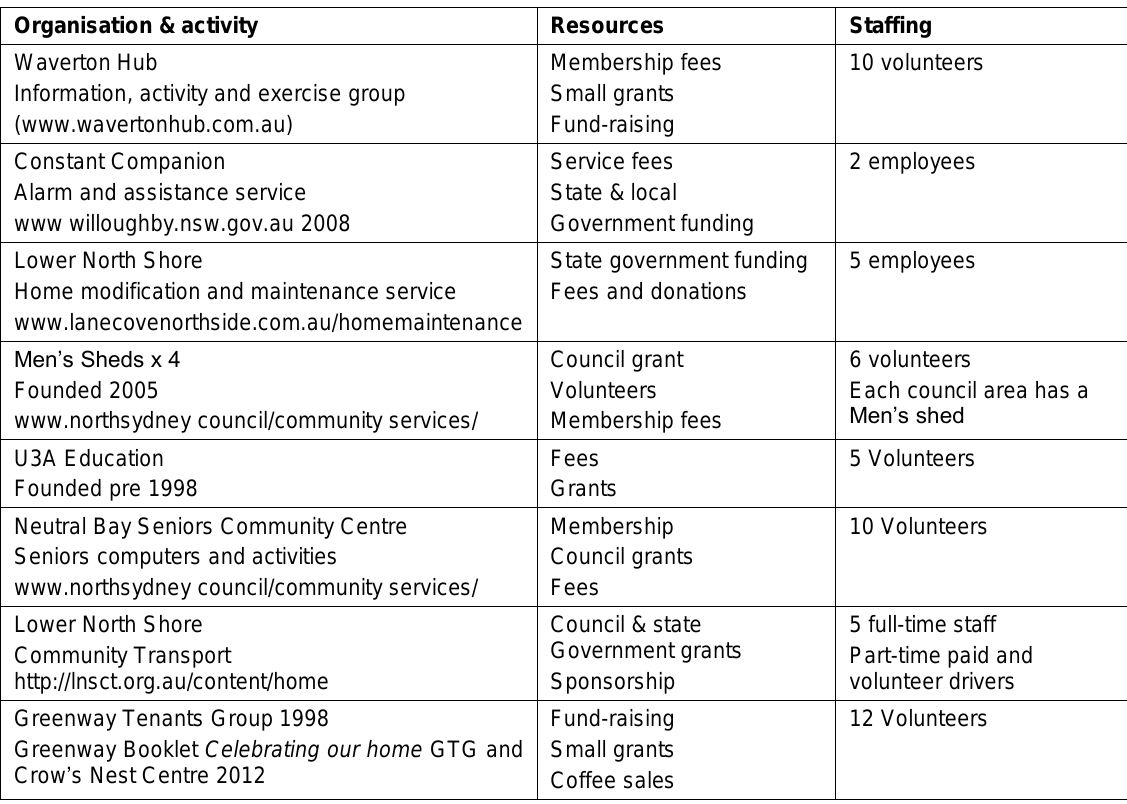
Table 1: Small organisations that provide services for older people in North